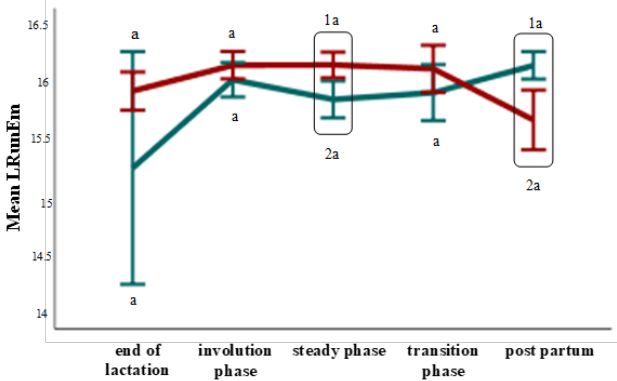
Figure 1. Long run emphasis changes among the periods and between the ewe groups ( p ≤ 0 .05). The different letter indicators (a, b) represent statistically significant differences between the periods, while the different number indicators (1, 2) represent statistically significant differences between the ewe groups in the same period. The green line represents the ewe group with healthy udders, while the red represents the ewe group with subclinical mastitis.